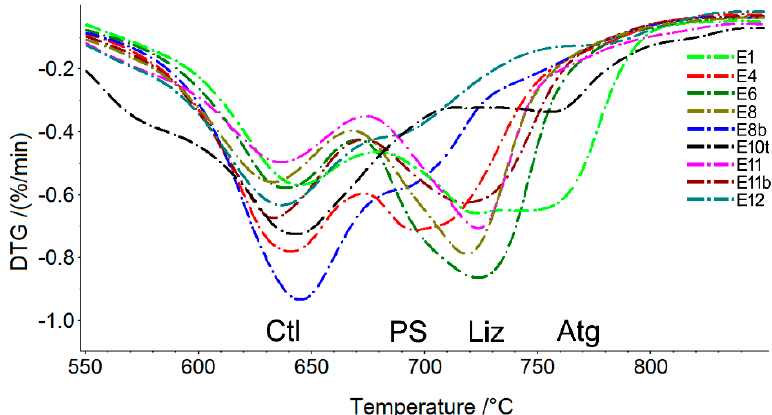
Figure 4. DTG curves for each sample in the temperature range of 500–850 °C. Endothermic peaks related to Ctl = chrysotile, PS = polygonal serpentine, Liz = lizardite, and Atg = antigorite. Mineral symbols after [38].